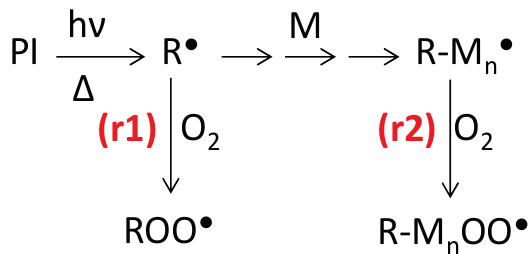
Scheme 1. Different polymerization reactions under oxygen (r1: initiating step and r2: propagation